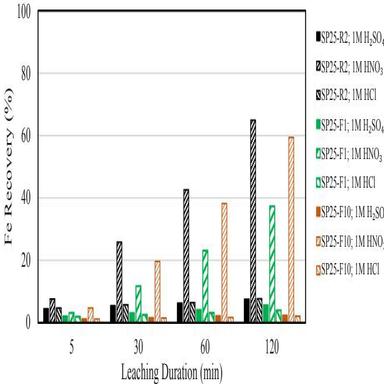
Leaching recoveries of iron from the Guxu core samples.